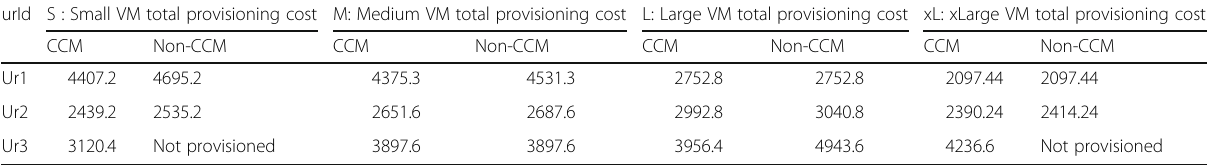
Table 5 A sample of provisioning cost of CCM vis-à-vis its non-coordinated